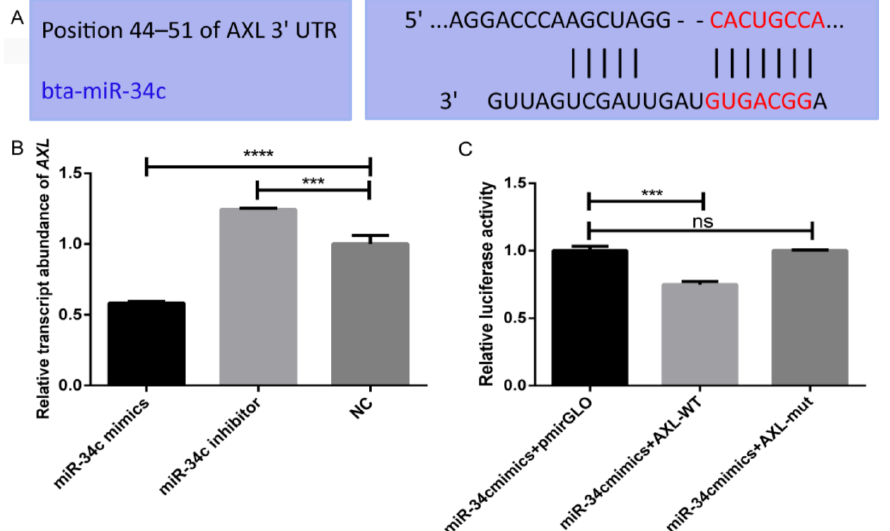
Figure 4. Verification of the target relationship between miR-34c and the AXL gene. ( A ) Sequence information of the binding site in the 3 (cid:48) UTR of AXL by TargetScanHuman 7.2. ( B ) The relative abundance of the transcript of the AXL gene. ( C ) Firefly and Renilla luciferase activities were measured after 48 h of transfection in Sertoli cells. *** p < 0.001; **** p <